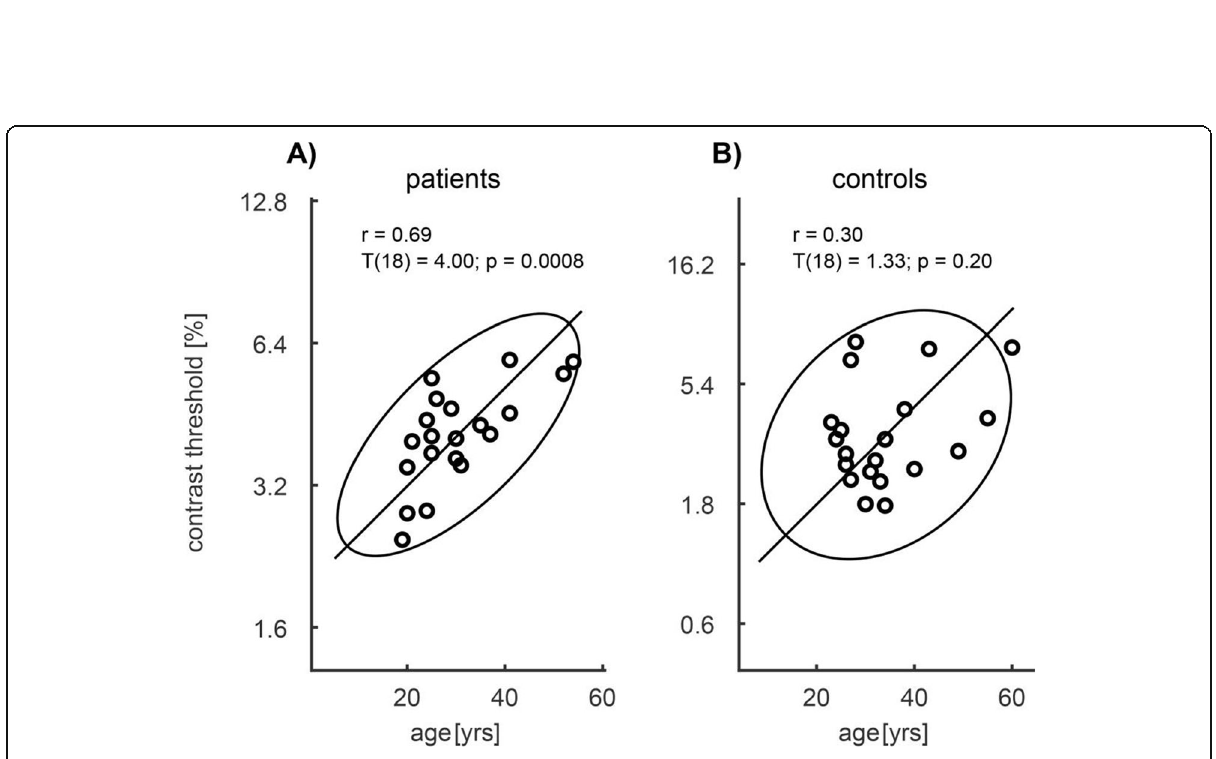
Fig. 2 Dynamic contrast threshold as a function of temporal flicker frequency [Hz] for VSS patients and controls. Bars and whiskers show the mean of the log10 (contrast threshold) and the 95% confidence interval of the mean. Each cross indicates the threshold of a single subject. VSS patients showed higher contrast thresholds at 15 Hz (asterisk, p < 0.01) but did not differ from controls at higher frequencies